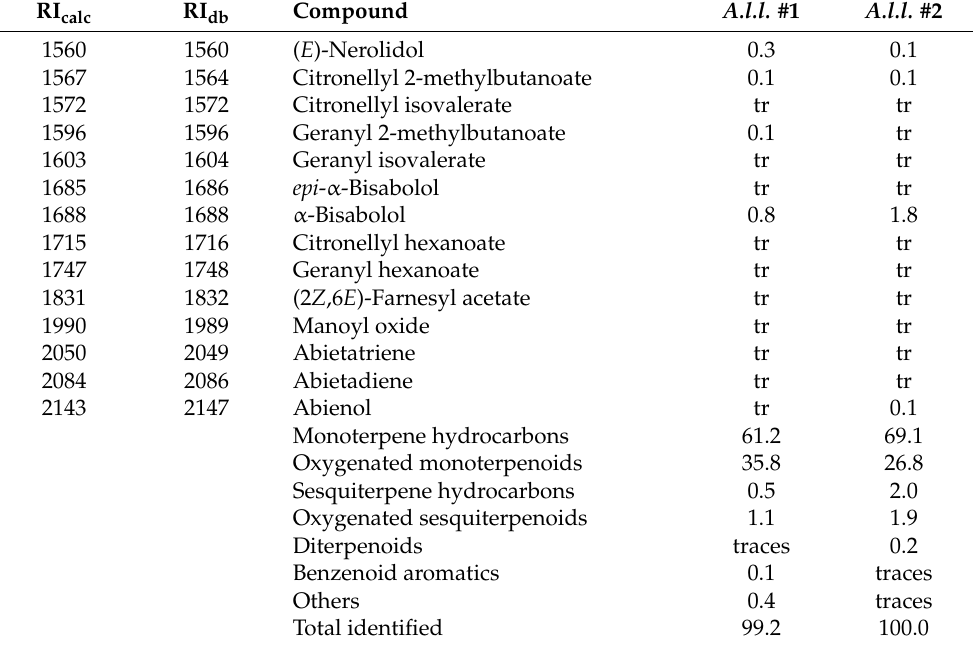
Table 1. Cont. RI calc